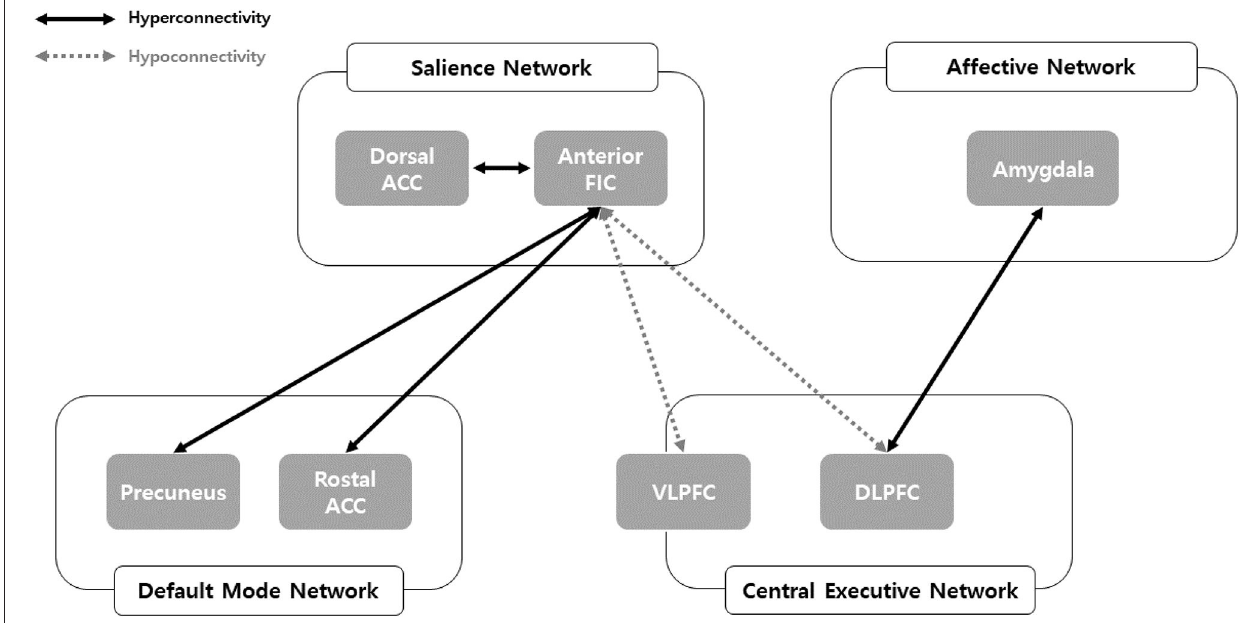
FIGURE 3 | Network model of problematic smartphone users. ACC, anterior cingulate cortex; DLPFC, dorsolateral prefrontal cortex; FIC, frontoinsular cortex; VLPFC, ventolateral prefrontal cortex.